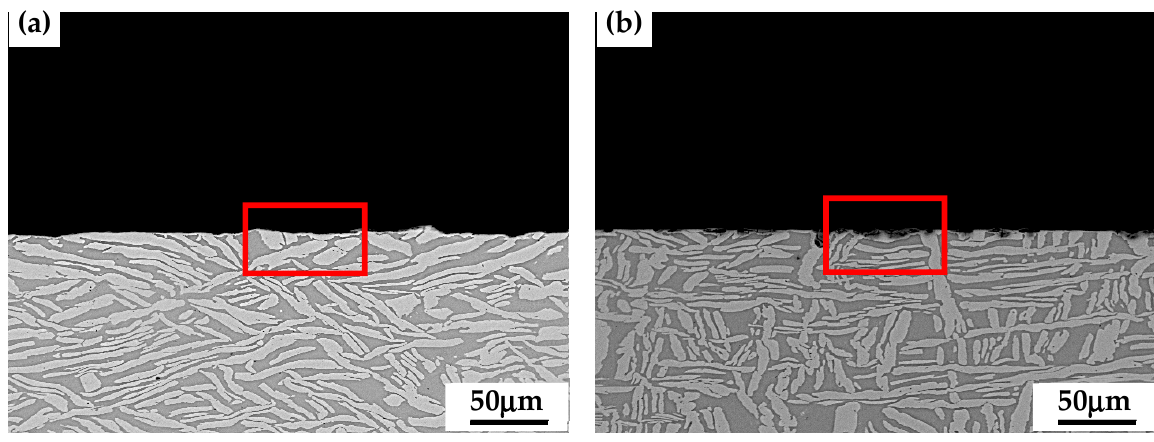
Figure 9. SEM observations to the cross-sectional morphologies of the immersed samples in solu- tions of: ( a ) 0.9 wt.% and ( b ) 3.5 wt.% NaCl solutions for 4 h, respectively. Images ( c ) and ( d ) are high magnification observations to the areas squared in images ( a ) and ( b ), respectively. 4. Conclusions Through investigating and comparing the corrosion behavior of an as-rolled Mg- 8%Li alloy in differently concentrated NaCl solutions, two conclusions can be drawn: (1) Based on the determined slopes of the measured hydrogen evolution curves, the cor- rosion rate of the alloy in the 3.5 wt.% NaCl solution is 3 times higher than that in the 0.9 wt.% NaCl solution when the immersion time exceeds 8 h. (2) The corrosion mechanisms of the as-rolled Mg-8%Li alloy are obviously different in the two concentrated NaCl solutions. In the 0.9 wt.% NaCl solution, the corrosion attack mainly occurs at the α -Mg phase. In the 3.5 wt.% NaCl solution, the corrosion attack initially occurs in the α -Mg phase and then gradually extends to the β -Li phase. Author Contributions: Funding: This work was supported by the National Natural Science Foundation of China Projects under Grant [Nos. 52071220, 51871211, U21A2049, 51701129 and 51971054], Liaoning Province’s project of “Revitalizing Liaoning Talents” (XLYC1907062), the Doctor Startup Fund of Natural Sci- ence Foundation Program of Liaoning Province (No. 2019-BS-200), High level achievement con- struction project of Shenyang Ligong University (SYLUXM202105), Liaoning BaiQianWan Talents Program, the Domain Foundation of Equipment Advance Research of 13th Five-year